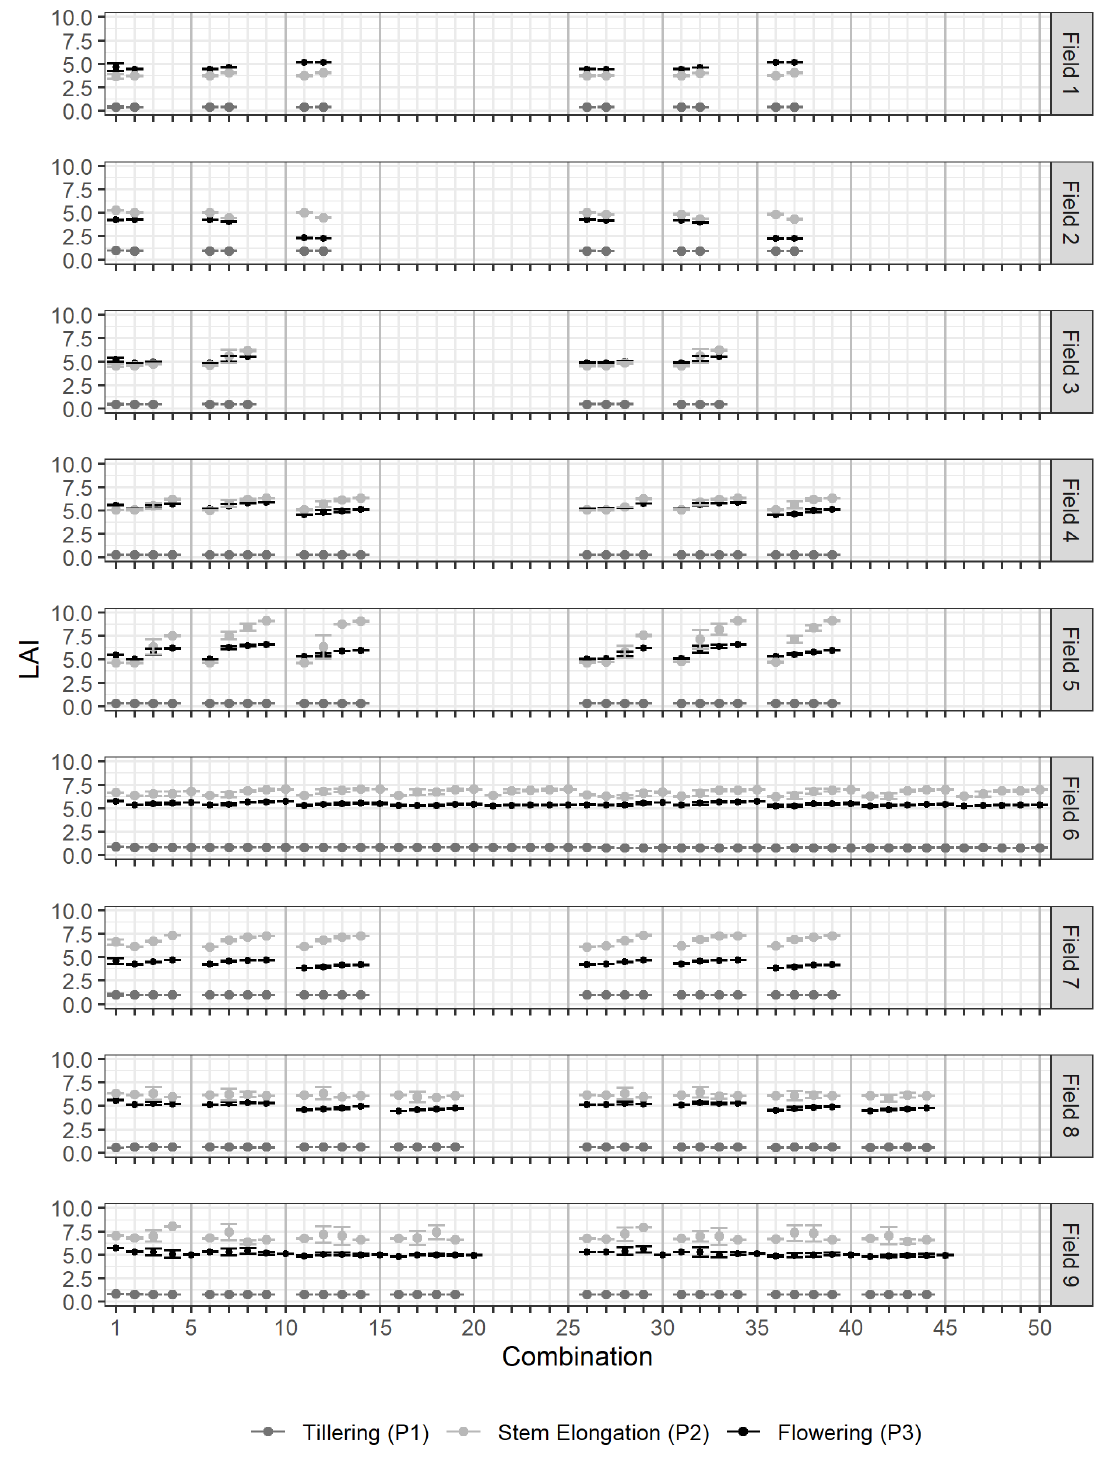
Figure A2. Average simulated LAI per field and combination at the end of the phases tillering (P1), stem elongation (P2) and flowering (P3). Error bars show standard deviation. See Table 2 for information about the composition of combinations.